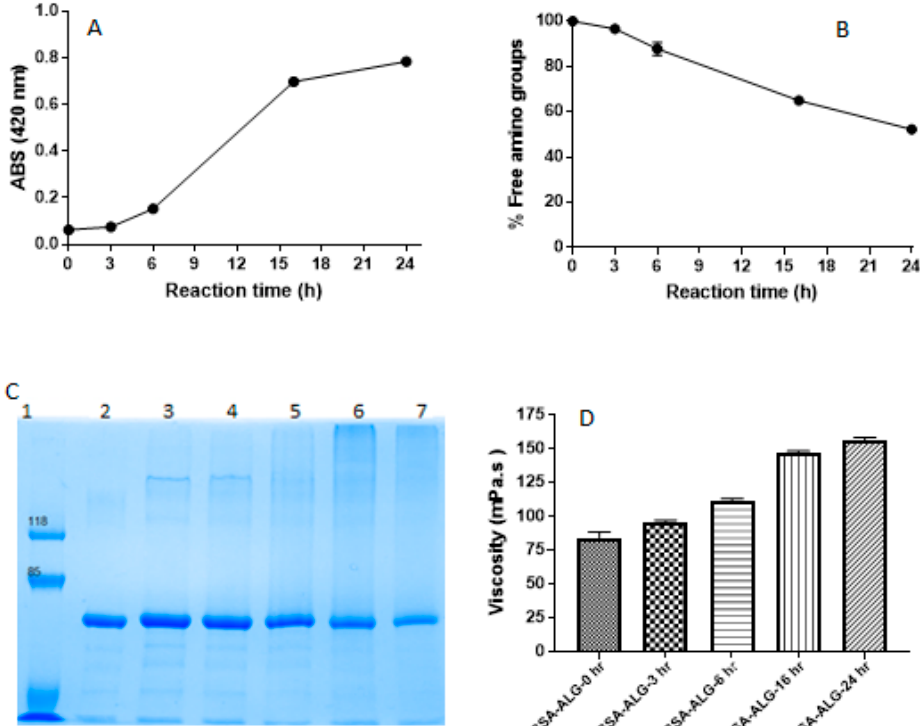
Figure 1. Changes in absorbance at 420 nm ( A ) and the remaining free amino groups (%) ( B ) of BSA-ALG conjugates (0, 3, 6, 16, and 24 h). ( C ) 8% sodium dodecyl sulfate polyacrylamide gel electrophoresis (SDS–PAGE) pattern of protein marker (lane 1), BSA (lane 2), and bovine serum albumin-alginate (BSA-ALG) conjugates reacted for 0, 3, 6, 16 and 24 h (lanes 3 to 7, respectively). ( D ) The viscosity (mPa · s) of BSA-ALG conjugates (0, 3, 6, 16, and 24 h) solution. (Mean ± SD, n = 3, error bars within the data point symbol).